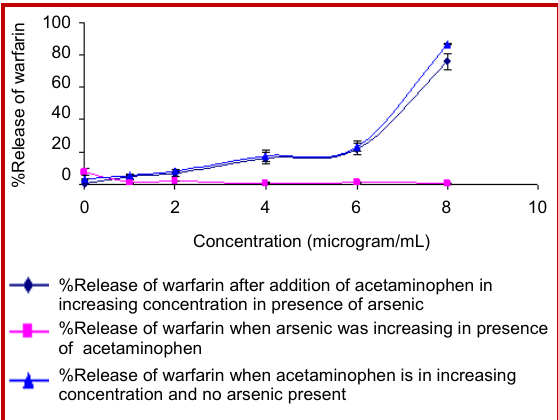
Figure 3: %Release of warfarin from protein binding site in